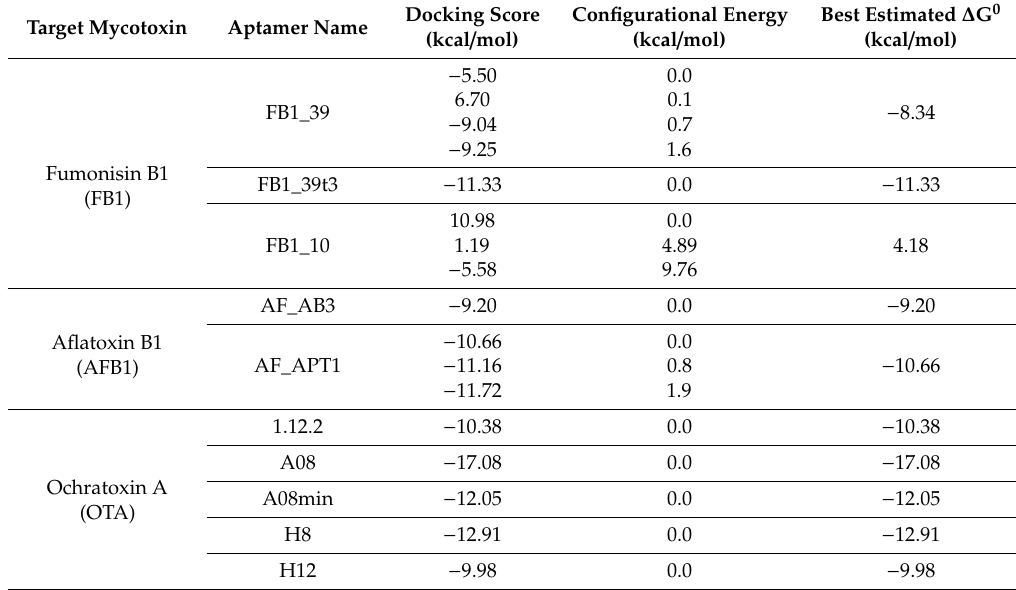
Table 2. Docking score values and relative DNA configurational energy calculated by using the in-silico approach for each of the selected aptamer towards target mycotoxin. ∆ G 0 is estimated as the sum of docking score and configurational